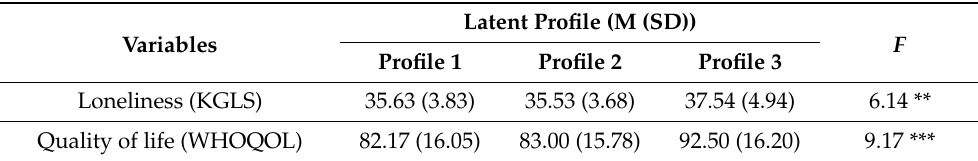
Table 4. Profiles comparison on mental health and quality of